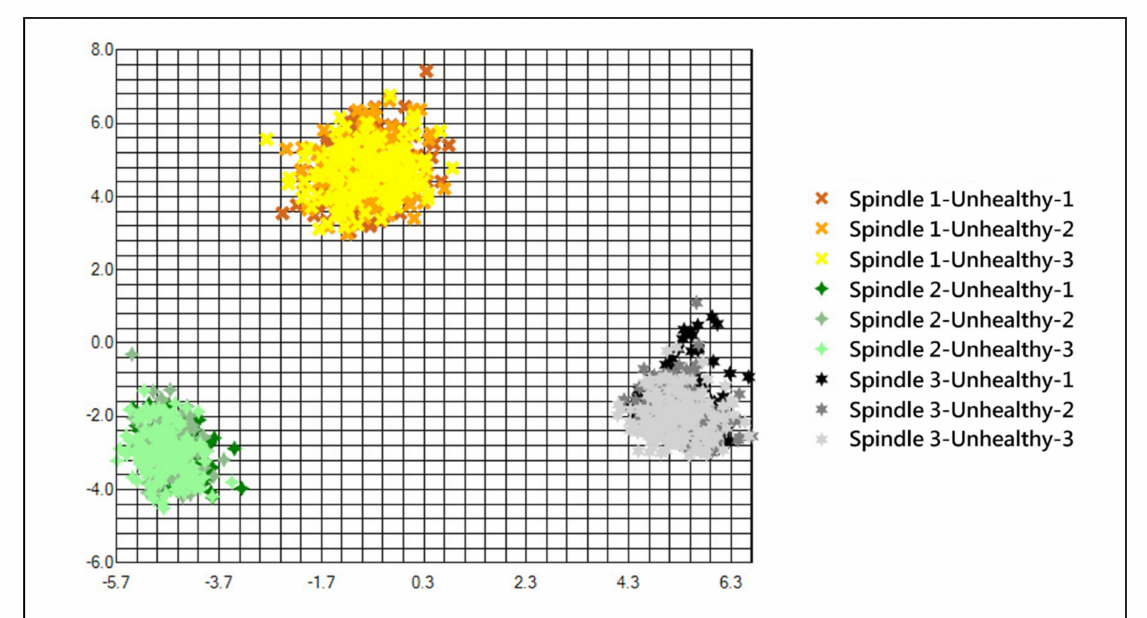
Figure 9. Spindle unhealthy state distribution